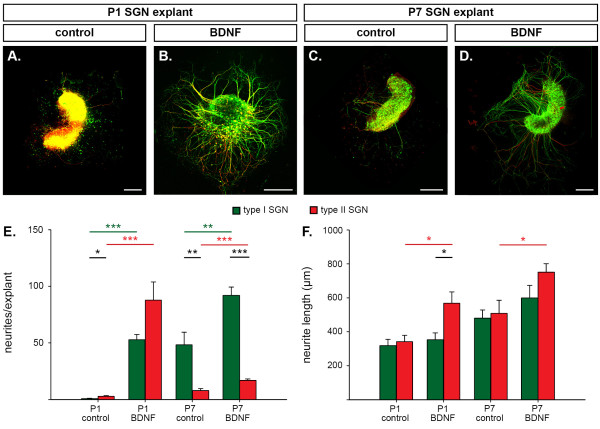
Brain-derived neurotrophic factor (BDNF) promotes neuritogenesis of both type I and type II spiral ganglion neurons (SGNs) in explants, but has a greater effect on type II SGNs. (A-D) Analysis of neurite outgrowth in mid-apical-mid-turn region explants from P1 (A,B) and P7 (C,D) mouse cochlea following 48 hour culture in control culture media (A,C) or with 100 ng/ml BDNF added to the media (B,D). Confocal immunofluorescence images show type I SGN neurites (β-tubulin (green) only) and type II SGN neurites (β-tubulin and peripherin (red)). (E,F) BDNF stimulated an increased number of type I (green) and type II (red) neurites per explant (E) and significantly longer type II neurites (F). The neurites extend from the explants in bundles and then separate into individual fibers. This gives the appearance of branching towards the ends in the low magnification images. Data are represented as mean and standard error of the mean; unpaired t-test, *P < 0.05, **P < 0.01, ***P < 0.001. Scale bars: 250 μm.